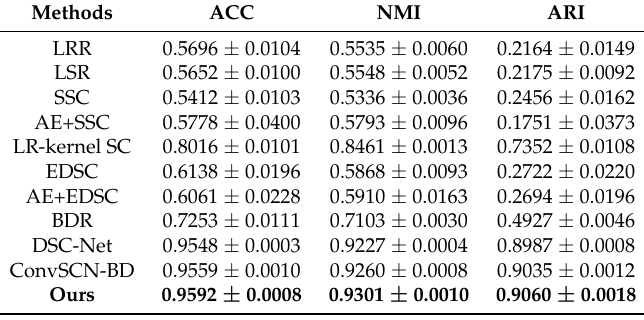
Table 2. Clustering performance of different algorithms on the Extended Yale B database.